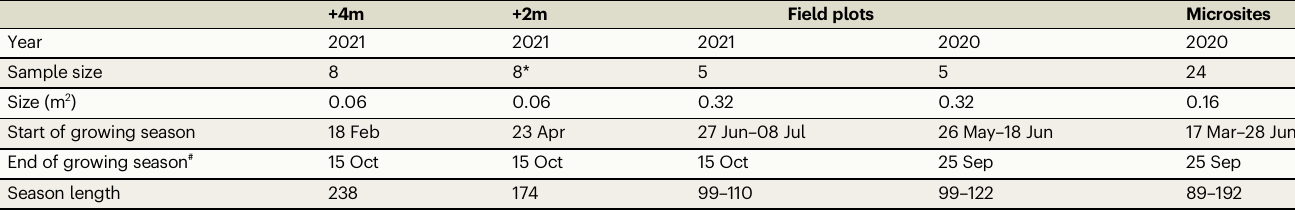
Table 1 | Characteristics of each experimental group (+4 m, +2 m, fi eld plots) and microsites